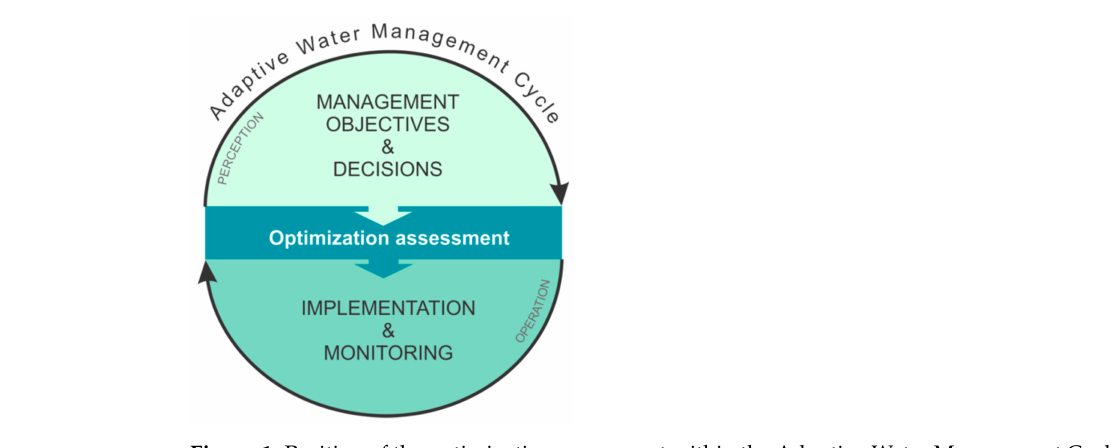
Figure 1. Position of the optimization assessment within the Adaptive Water Management Cycle. The phases of an AWMC can be divided into two main stages belonging to opposite edges of the action spectrum: perception–understanding and operational. The first stage involves the definition of the management objectives and management decisions; the second stage focuses on the implementation and monitoring of the management actions to provide insight into the next cycle, respectively.